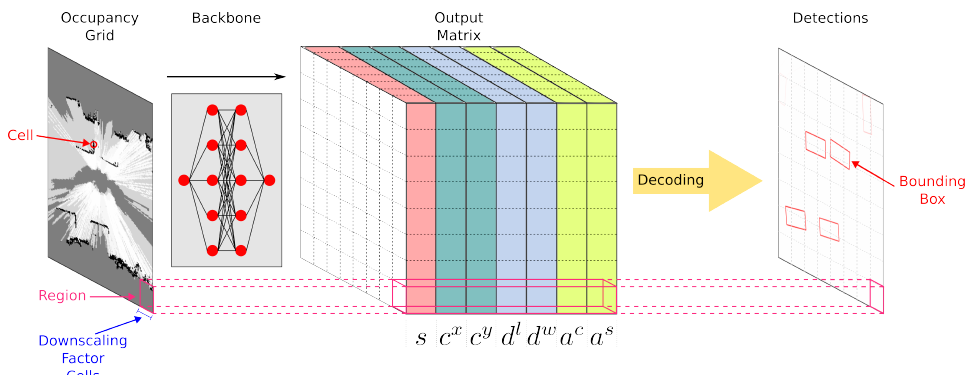
Figure 1. Illustration of the input occupancy grid map, the output matrix encoding the proposed bounding boxes and the detections once decoded from the output